Question: Author a descriptive caption for the visualization shown.
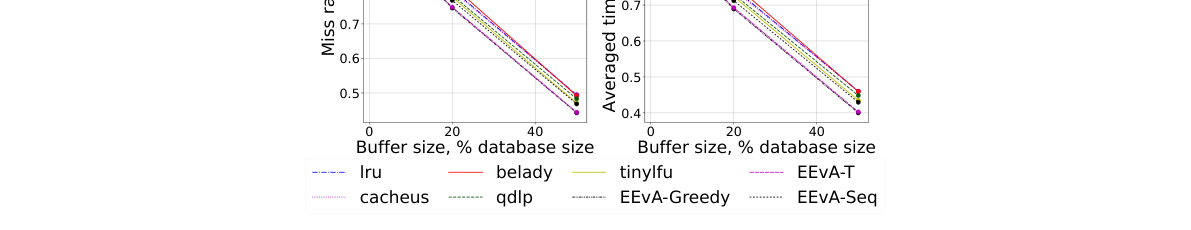
Answer: Comparison in the scenario with rare scan-type queries. The lower the miss rate and averaged time costs, the better the performance is. EEvA-based algorithms show a superior performance over the competitors wrt both metrics.